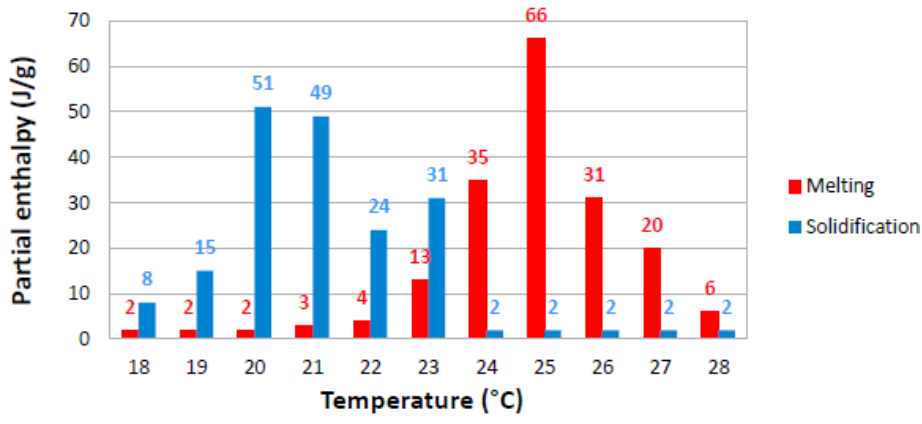
Figure 2. Enthalpy distribution (3 °C/h) of Inertek 23 (DSC, measurement by MCI Technologies). Table 2. Composition of the ETMV 8 coating.